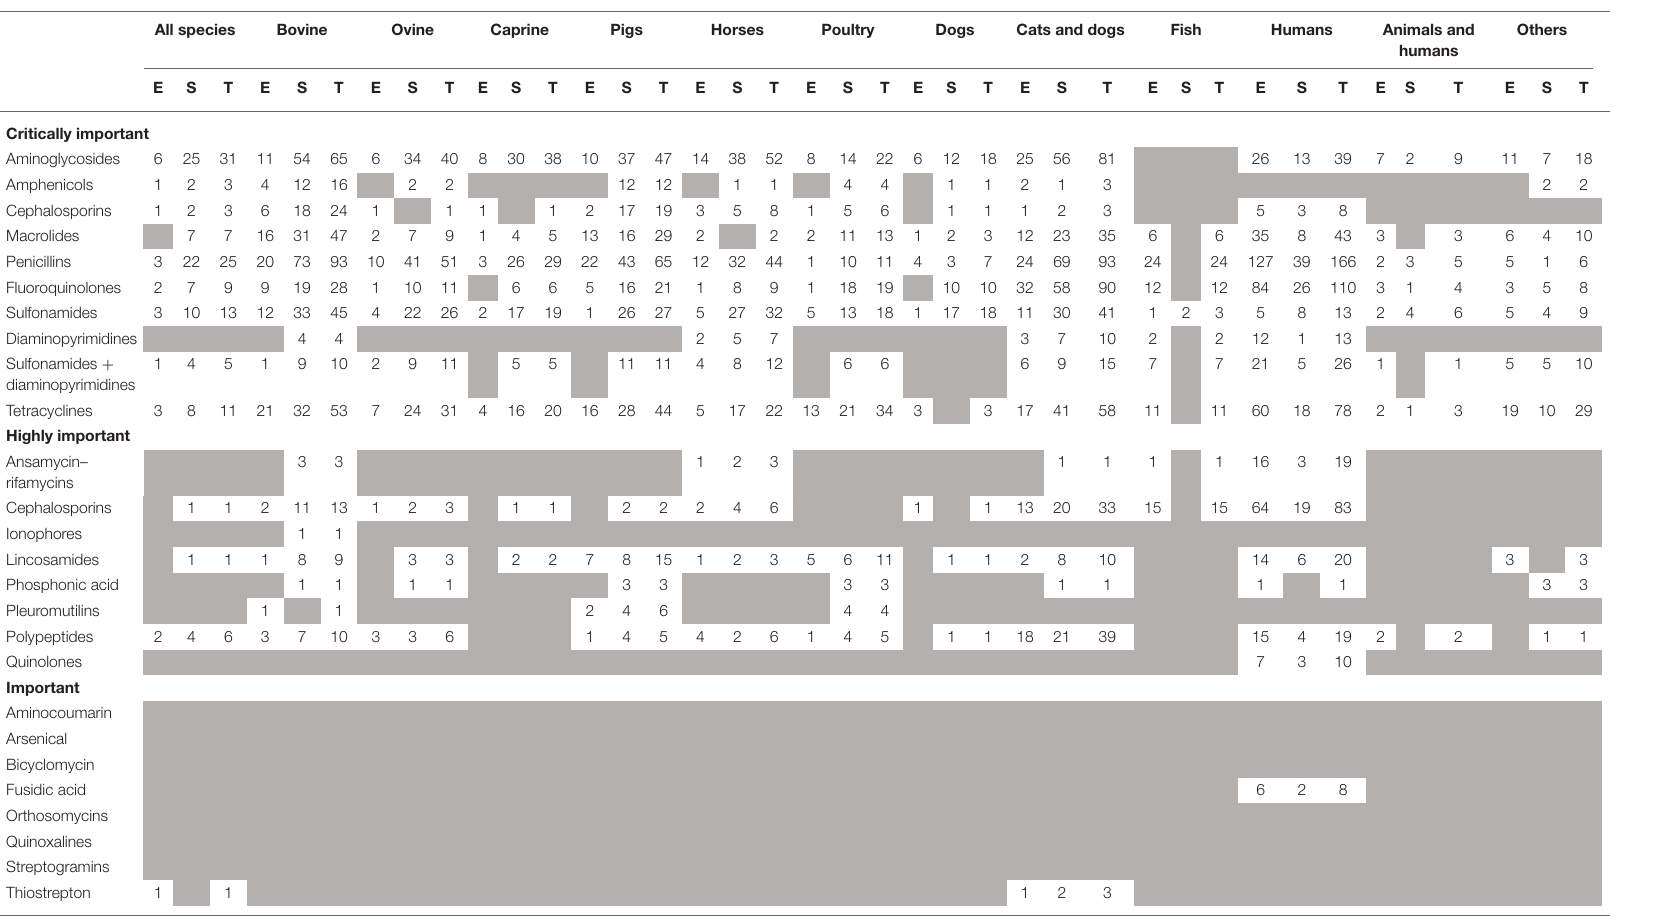
The numerical value corresponds to the sum of the web pages where each of the individual antibiotics included in the family is sold. The names of the individual compounds included in each family are detailed in Table 1 . The number of websites selling each individual antibiotic according to the species they are intended to are included in Supplementary Table S3 . Cells shaded in gray indicate zero offers. E, search in English; S, search in Spanish; T,